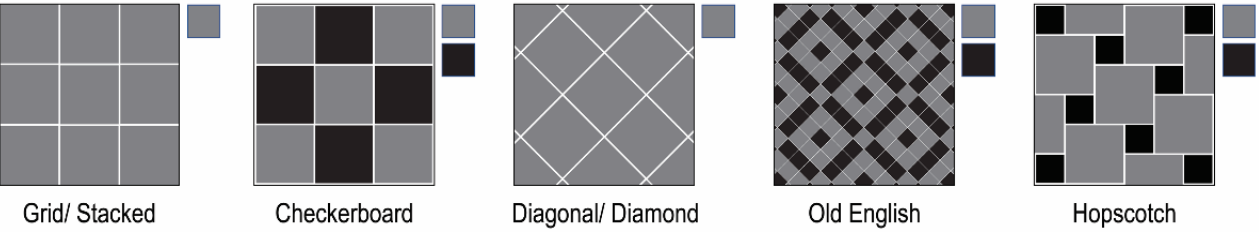
Figure 2. A square tile arranged in various layouts. (Illustration by Kunkhet).